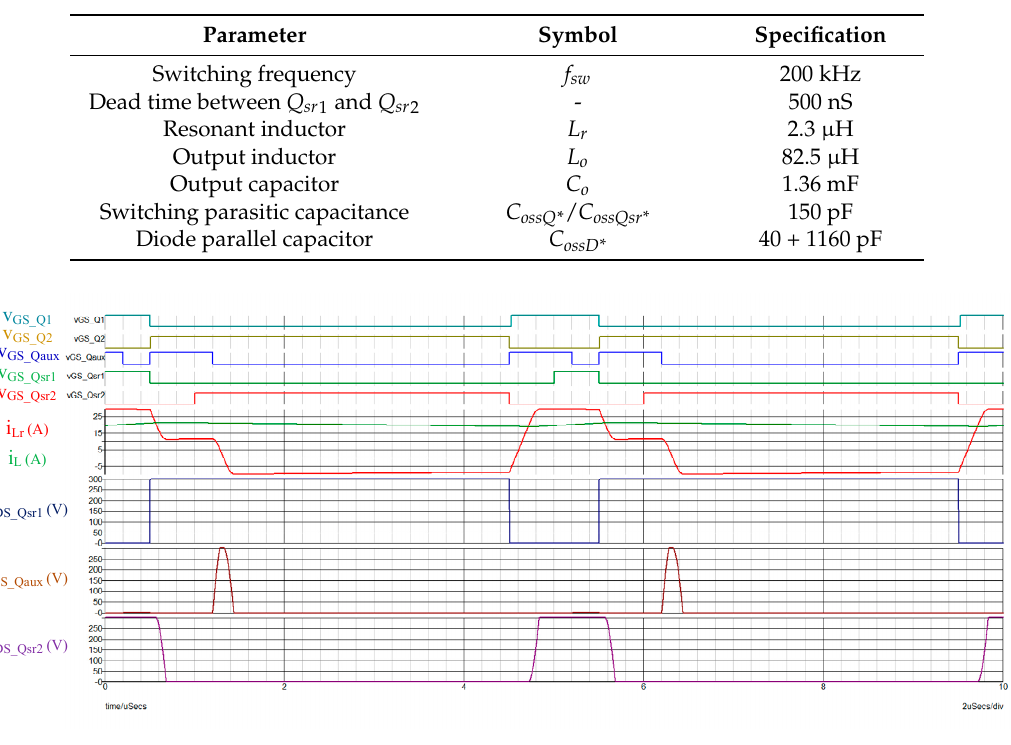
Table 1. The key simulation parameters.